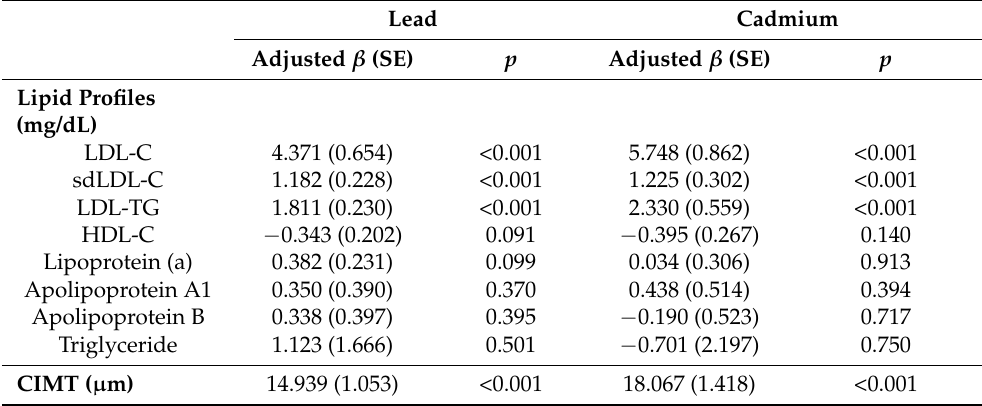
Table 2. Linear regression coefficients (standard error) of lipid profiles and CIMT with a unit increase in ln-urine heavy metal concentration ( µ g/g creatinine) in the multiple linear regression models ( n = 736).